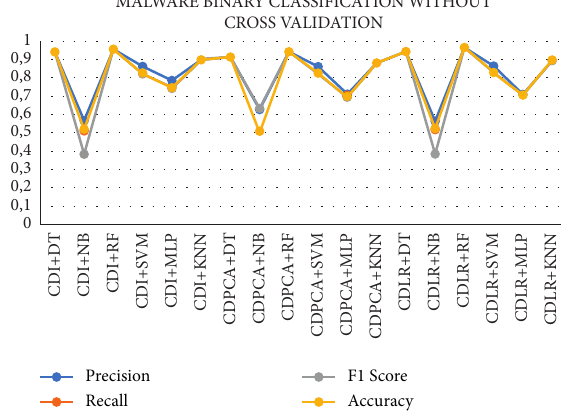
Figure 4: Experimental result of malware binary classification without cross-validation. Table 8: Binary classification results using cross validation with N �